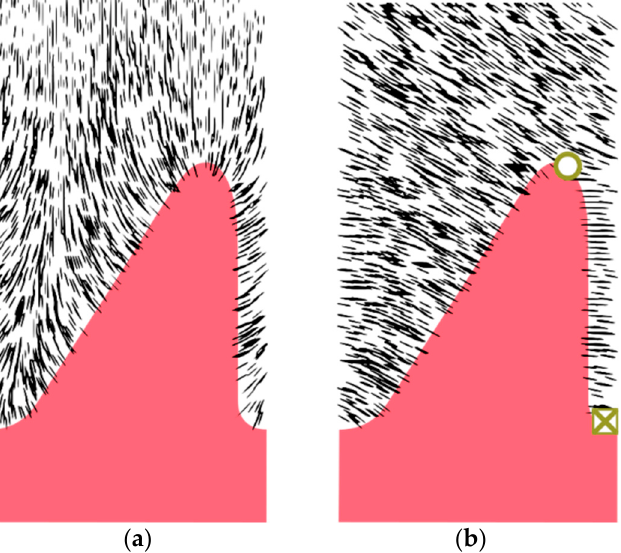
Figure 7. Modelled director alignments near the grating surface for continuous ( a ) and defect ( b )